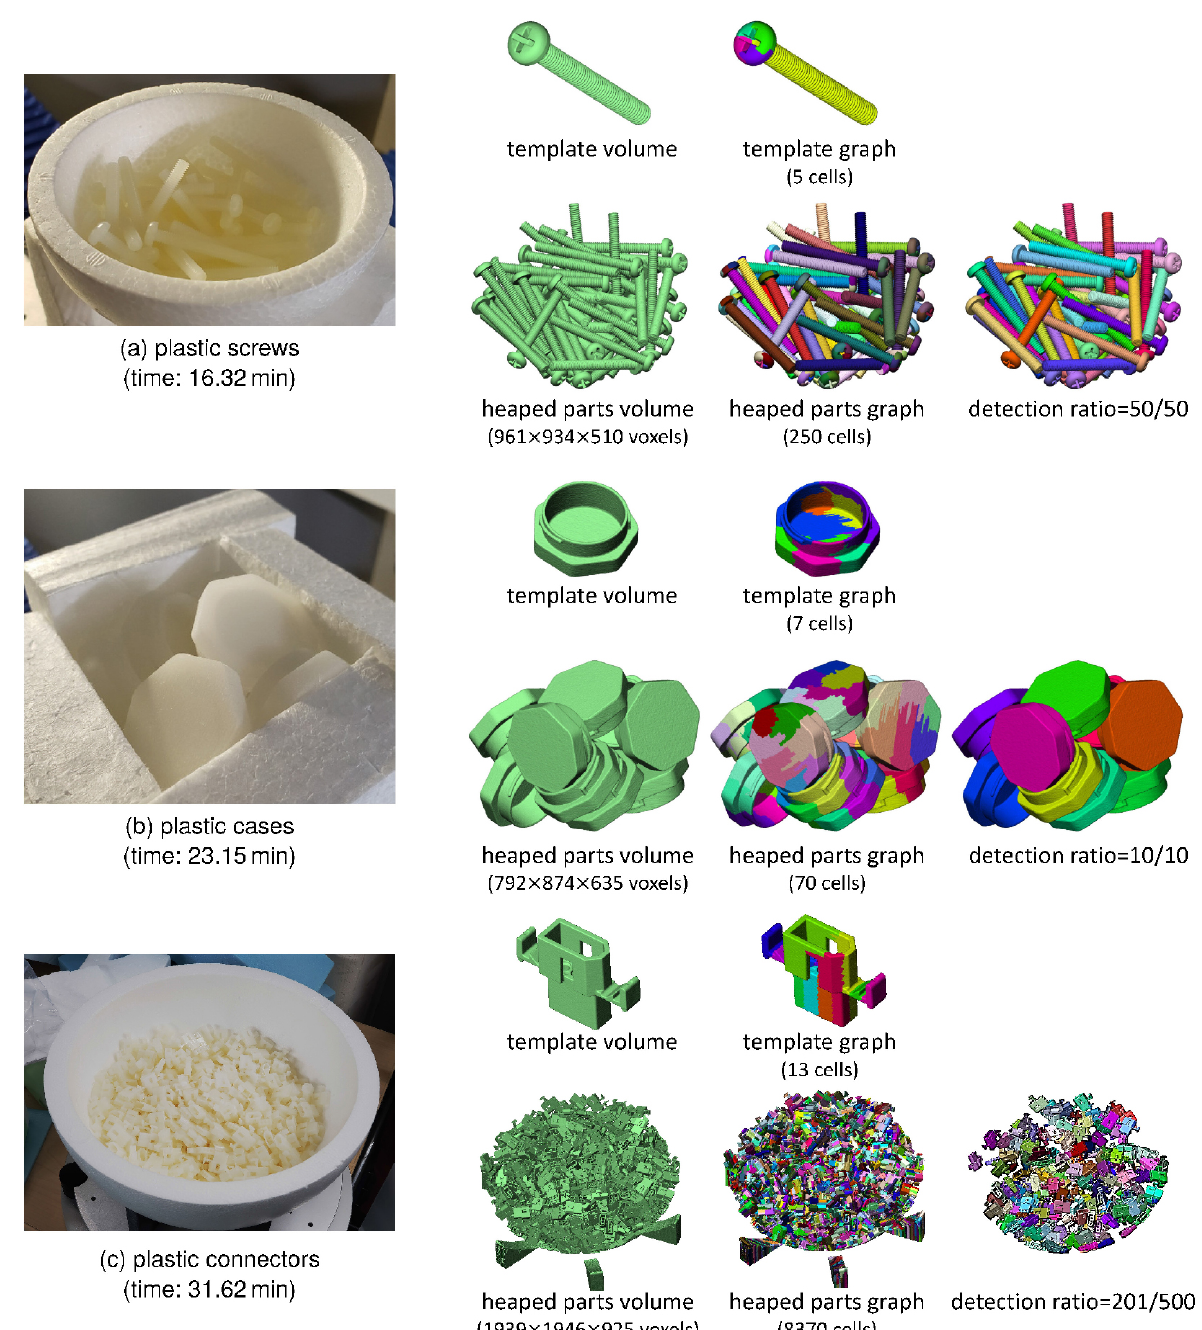
Fig. 6 Experimental results in segmenting bin-scanned heaps of three different parts, i.e., (a) plastic screws, (b) plastic cases, and (c) plastic connectors. The computation time for each is shown at the bottom of the respective photo. To the right of this figure, template volume and its corresponding MSG is shown at the top. The volume of heaped parts, its corresponding MSG, and detected parts are shown at the bottom. In these images, volume data are visualized by isosurfaces extracted by the Marching Cubes method. Different cells are highlighted in different colors in the images of MSGs, and different parts are highlighted in different colors in the images of detected